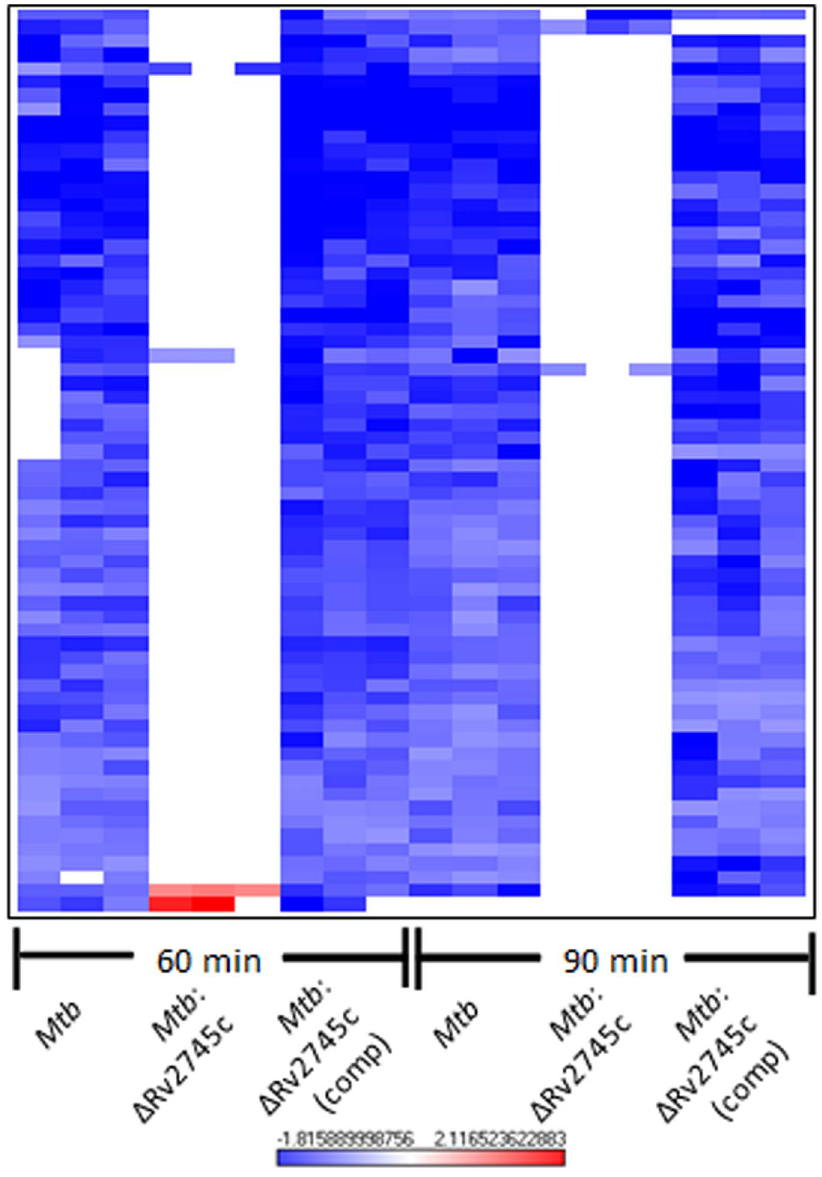
Figure 6. Diamide Repressed Genes. The heat map shows results of unsupervised hierarchial clustering focusing on genes with the greatest level of repression compared to the control channel. A majority of genes repressed in Mtb are also repressed in Mtb : D Rv2745c (comp) at both 60 and 90 minutes post-diamide treatment, whereas there is no change in expression levels in Mtb : D Rv2745c. n=3. Red color indicates induction while blue color indicates repression, relative to the control channel. The intensity of each color corresponds to the magnitude.